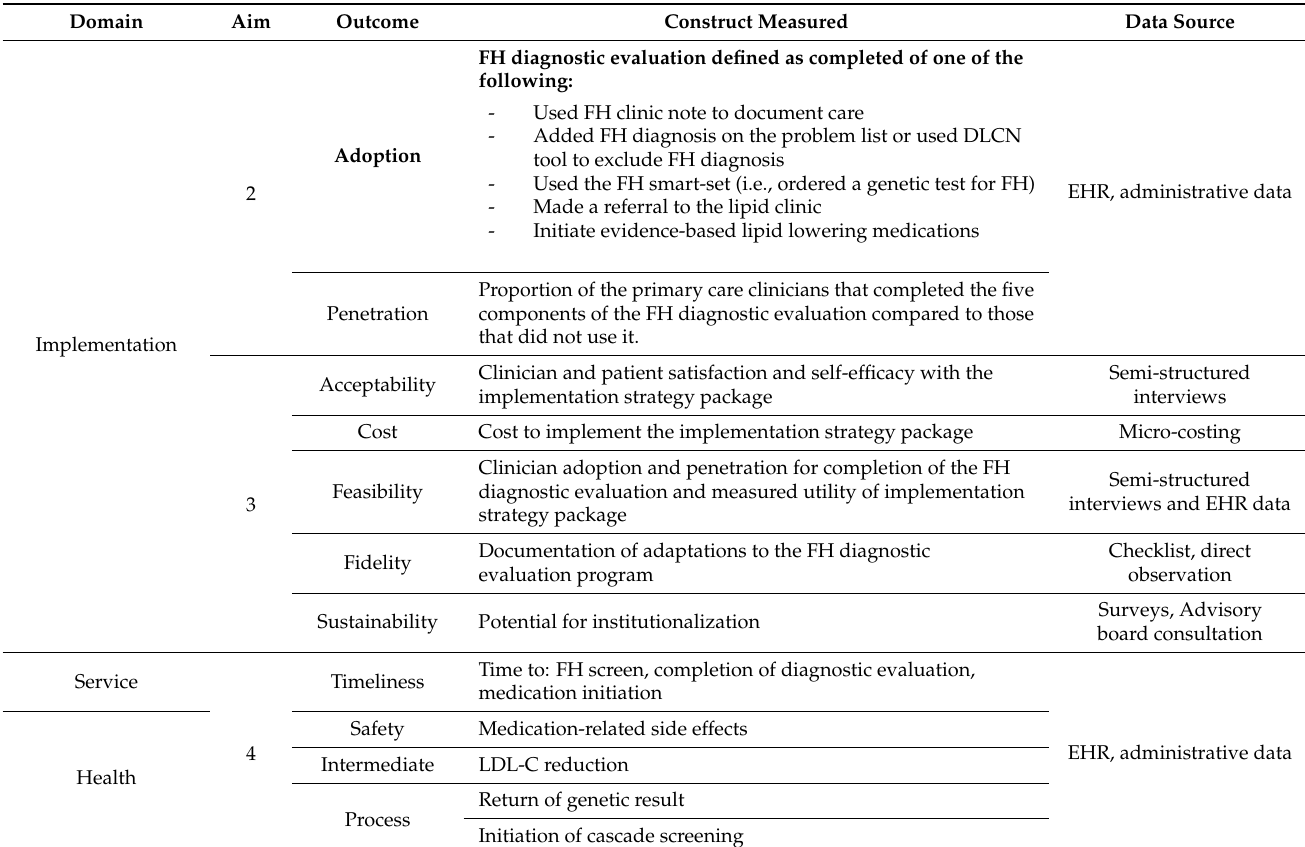
Table 2. Description of domains, aim, outcomes, construct measured, and data sources for phase two